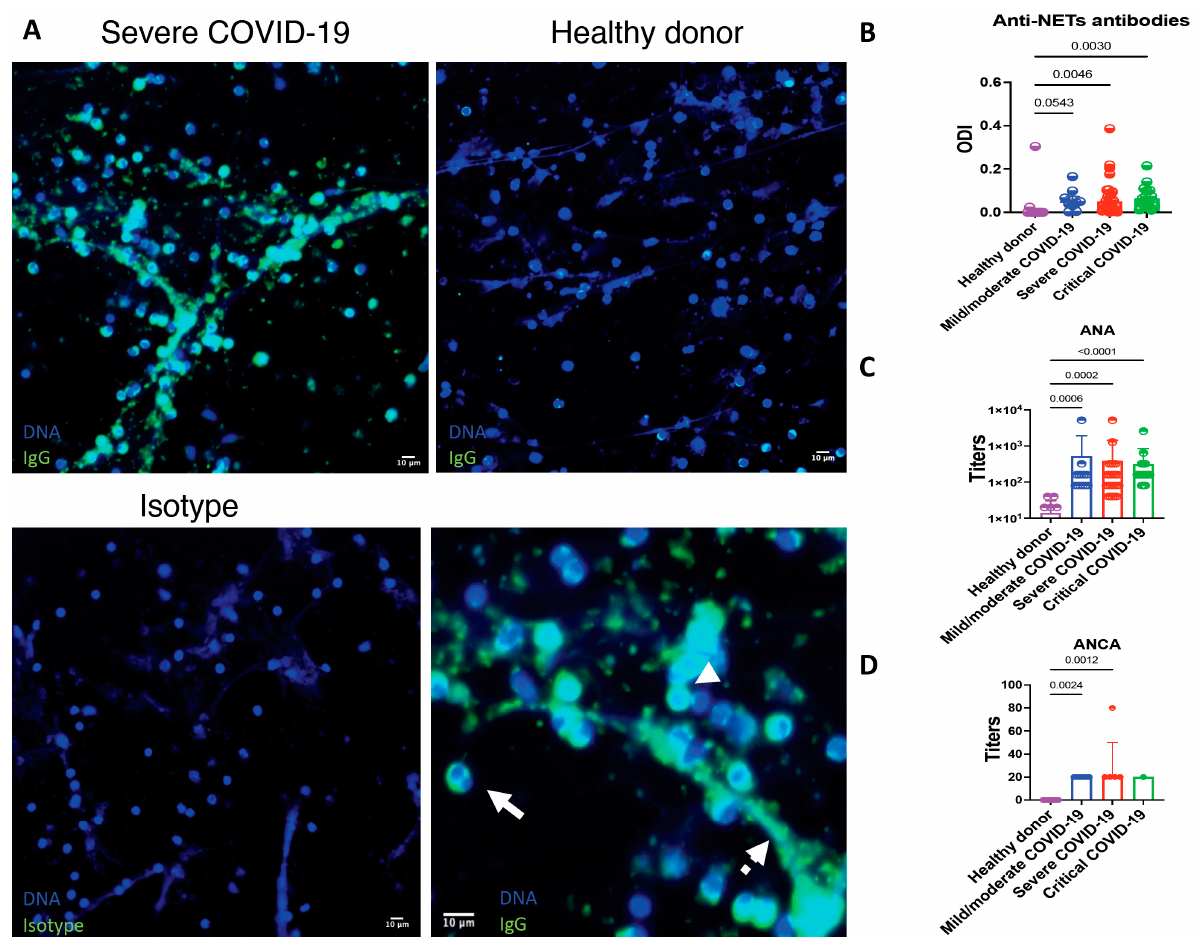
Figure 5. Patients with COVID-19 have antibodies that recognize neutrophils and NET’s antigens. ( A ) Healthy donor neutrophils were seeded on coverslips and stimulated with 2.5 mM PMA to induce the release of NETs. The samples were incubated with 10% sera from COVID-19 patients or healthy donors. Sera from COVID-19 patients show anti-neutrophil and anti-NET antibodies. The antigens recognized by anti-neutrophils and anti-NET antibodies include those located in the cytoplasm (continuous arrow), nucleus (arrowhead) and NETs (discontinuous arrow). The autoantibodies were not found in healthy donors. As the isotype control, the samples were incubated solely with the secondary antibody. ( B ) Relative amount of anti-NET antibodies expressed as the optic density index (ODI). ( C ) Titers of antinuclear antibodies expressed in a logarithmic scale. ( D ) Titers of anti-neutrophil cytoplasmic antibodies. Medians were compared using the Kruskal–Wallis and Dunn’s multiple comparison tests.